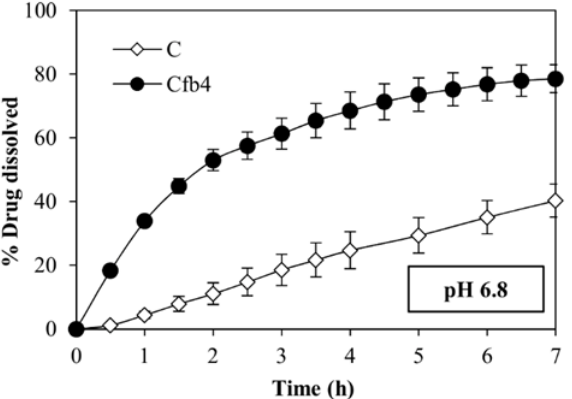
Figure 6. Dissolution profiles of carvedilol alone (C) and Cfb4 drug-loaded fibers in pH 6.8 buffer. All samples contain a dose of 6.25 mg of carvedilol.